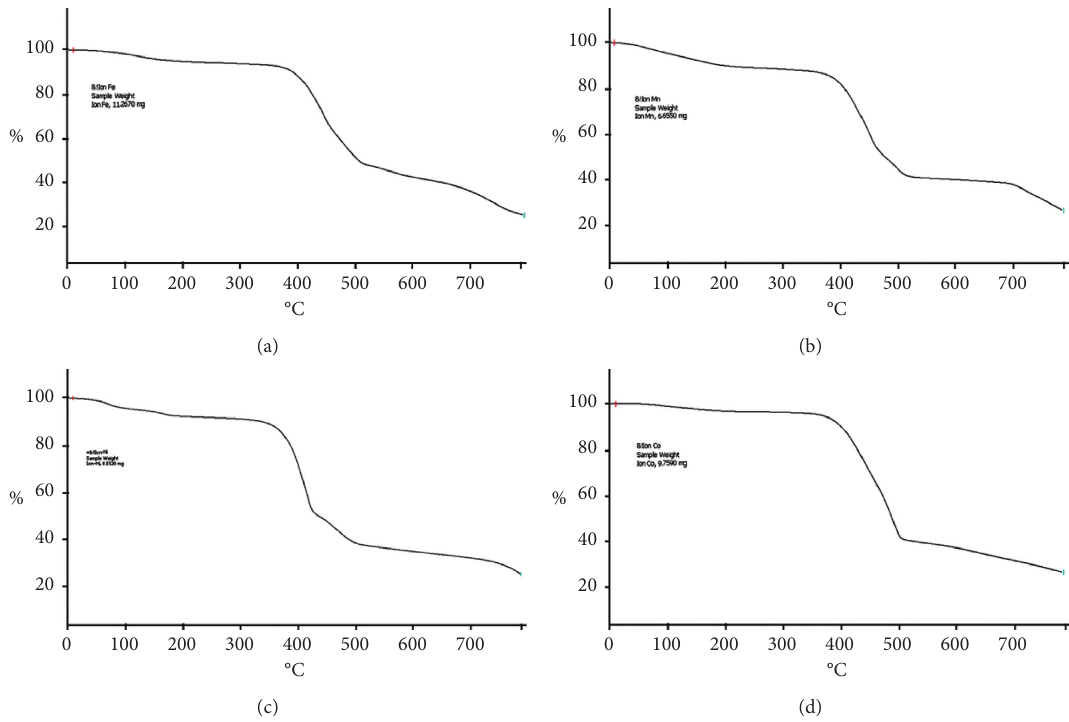
Figure 1: Thermal analysis of (a) [EMIM-Cl][FeCl 2 ], (b) [EMIM-Cl][MnCl 2 ], (c) [EMIM-Cl][NiCl 2 ], and (d) [EMIM-Cl][CoCl 2